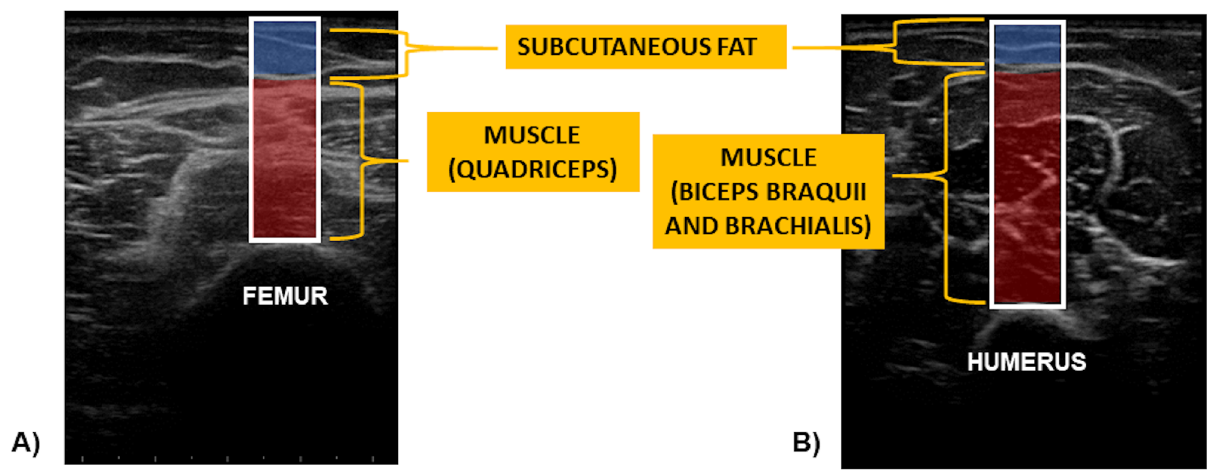
Figure 2. Range of interest (white rectangle) and areas selection of sample images ( A : quadriceps; B : biceps/